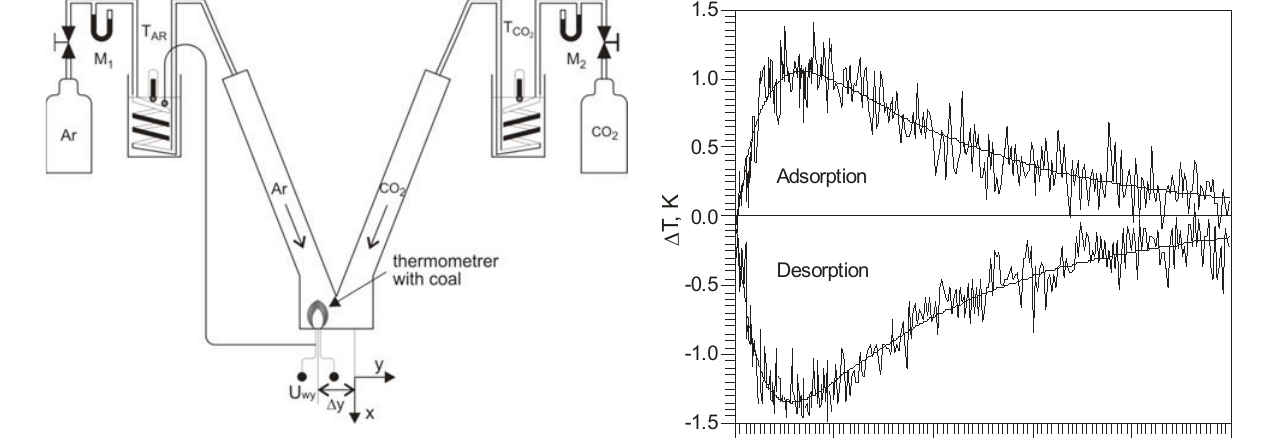
Figure 1: The principle of measuring the sorption time constant (Gawor and Skoczylas 2014).